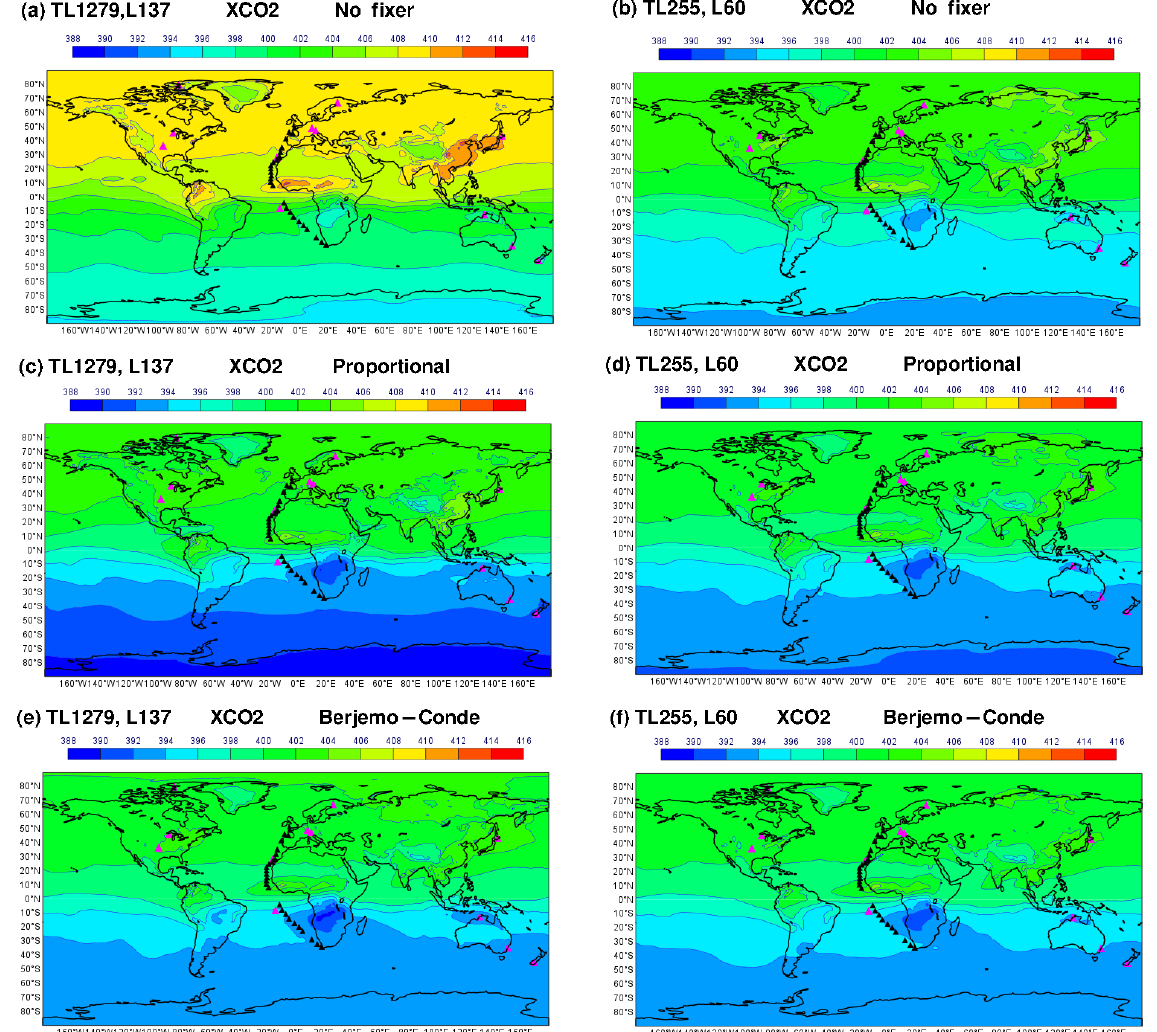
Figure 3. Mean XCO 2 (ppm) from 7 March to 10 April 2014 for the high-resolution (left panels) and low-resolution (right panels) simula- tions. The effect of the different mass fixers is shown in the different rows. Details of the simulations can be found in Table 1. The pink and black triangles mark the location of the reference observations from TCCON and Polarstern cruise respectively. See Table 2 for a list of the TCCON site